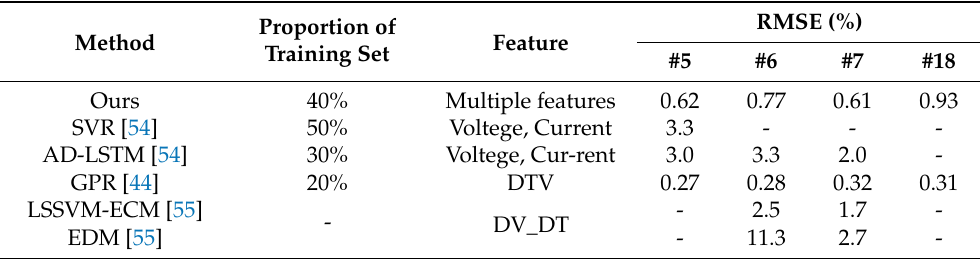
Table 5. RMSE of SOH estimation result on the NASA dataset.